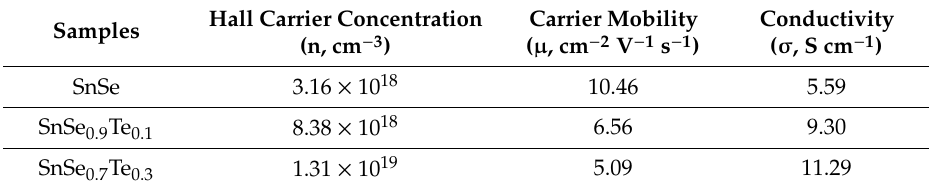
Figure 4. The temperature-dependency of ( a ) electrical conductivity ( σ ) and ( b ) Seebeck coefficient (S) of the polycrystalline SnSe 1 − x Te x (x = 0, 0.1, and 0.3). Table 2. Charge transport properties of polycrystalline SnSe 1 − x Te x (x = 0, 0.1, and 0.3). The carrier concentration (n), carrier mobility ( µ ), and electrical conductivity ( σ ) were measured at room temperature.